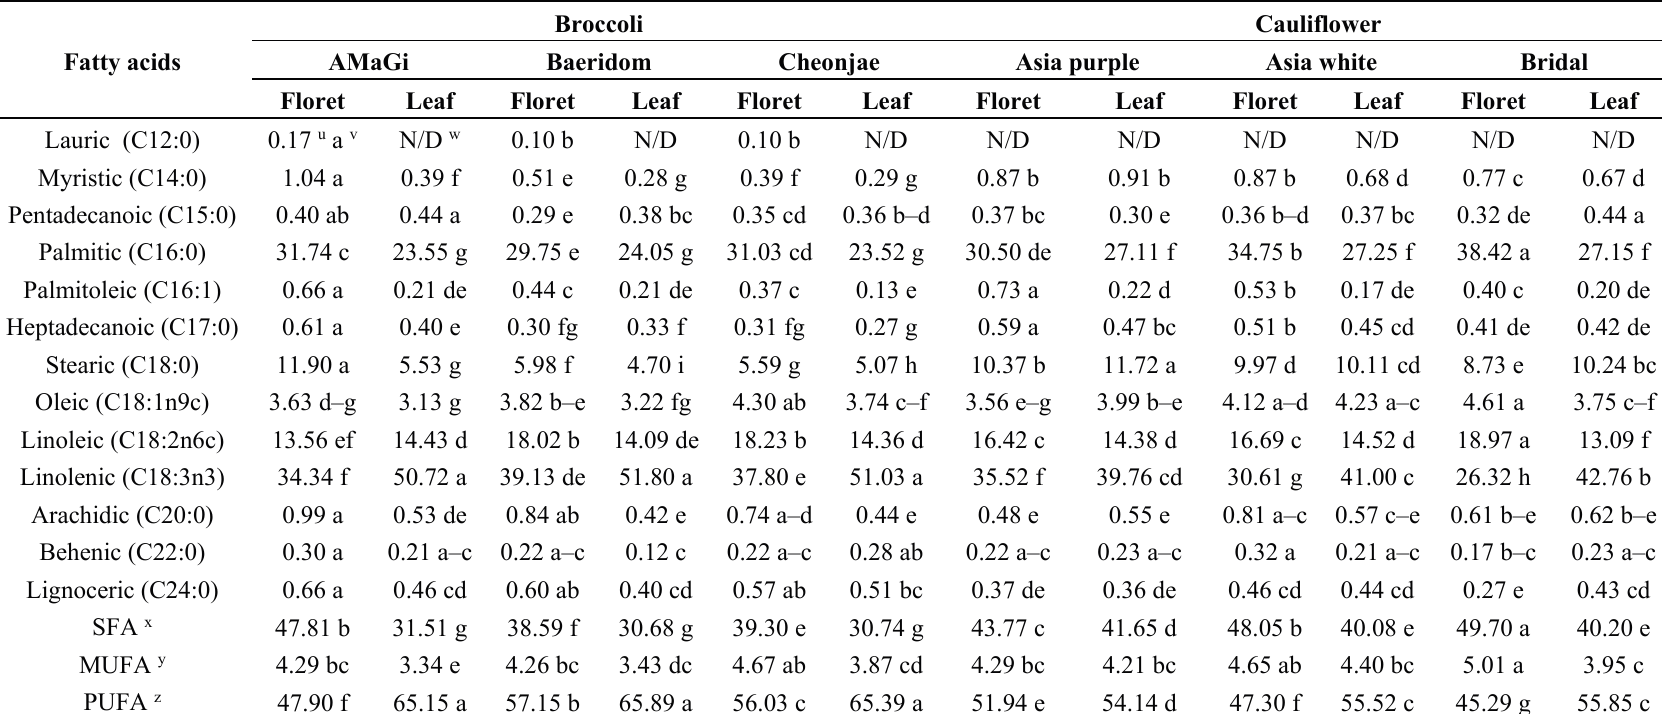
Table 3. Fatty acid composition (%) in various parts of broccoli and cauliflower cultivars. Broccoli Cauliflower Fatty acids AMaGi Baeridom Cheonjae Asia purple Asia white